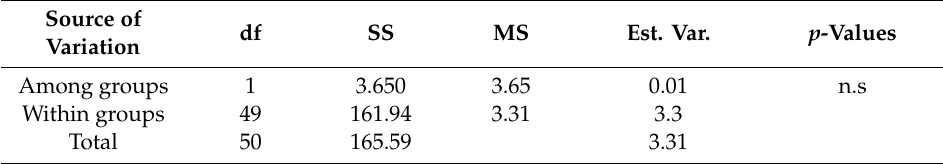
Table 3. Analysis of molecular variance (AMOVA) of faba bean collection split in samples collected by the National Gene Bank of Tunisia (NGBT) and Agricultural Research in the Dry Areas (ICARDA).